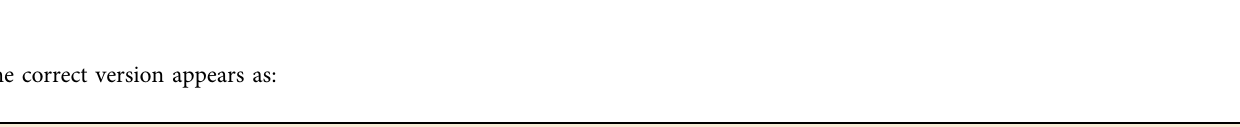
Table 3 Number of genes differentially expressed and methylated at 52 and exhibiting at least one CpG signi fi cantly correlated to the indicated clinical